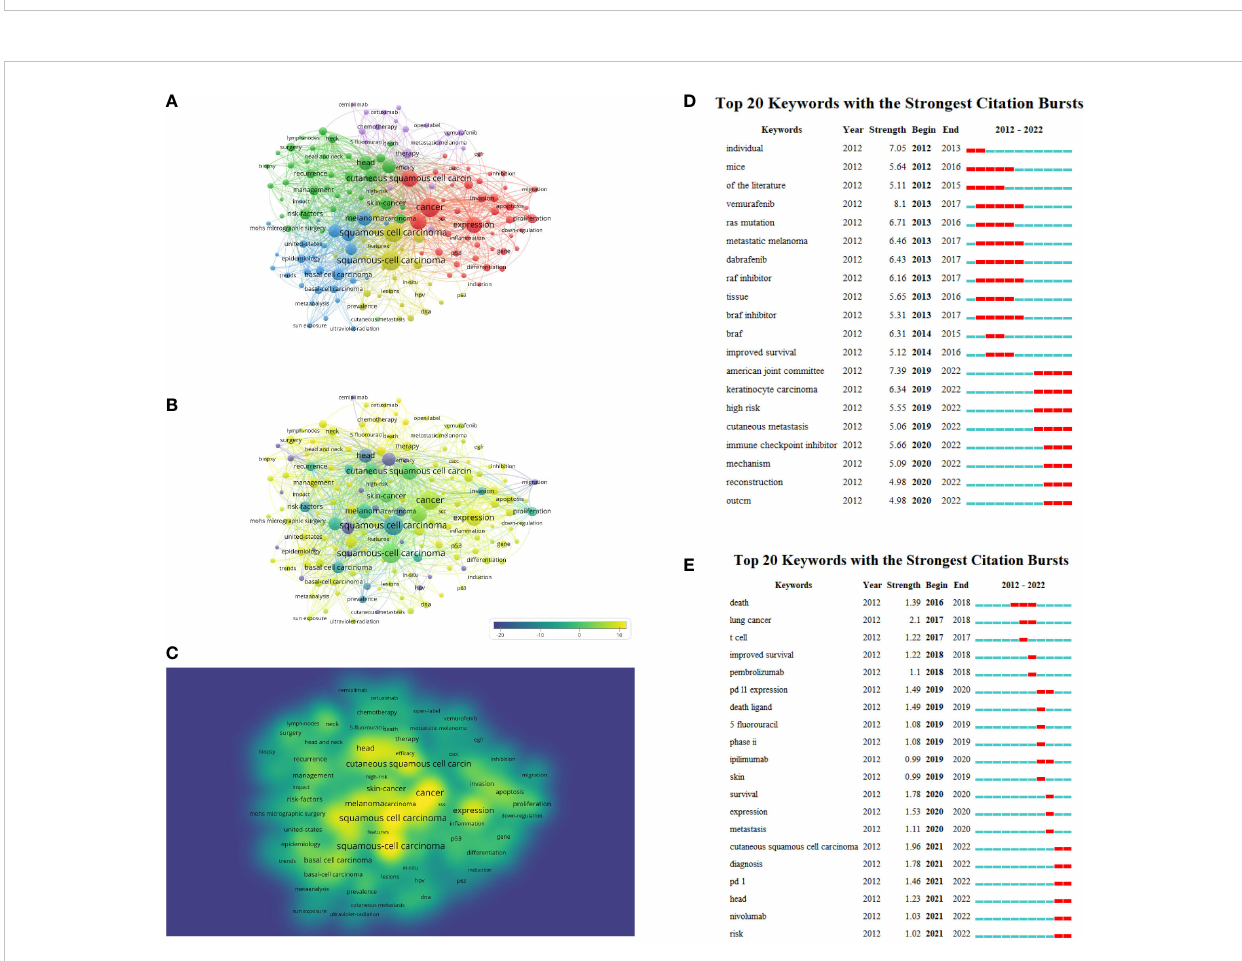
FIGURE 7 Keyword analysis diagram. (A) . Network visualization map of co-occurrence and clustering analysis of the frequent keywords. (B) .Co-occurrence and cluster analysis of frequent keywords in time-superimposed network visualization. (C) . Co-occurrence and cluster analysis of frequent keywords by density superposition network visualization. (D) .Keywords with the strongest citation bursts of CSCC. (E) . Keywords with the strongest citation bursts of programmed cell death in